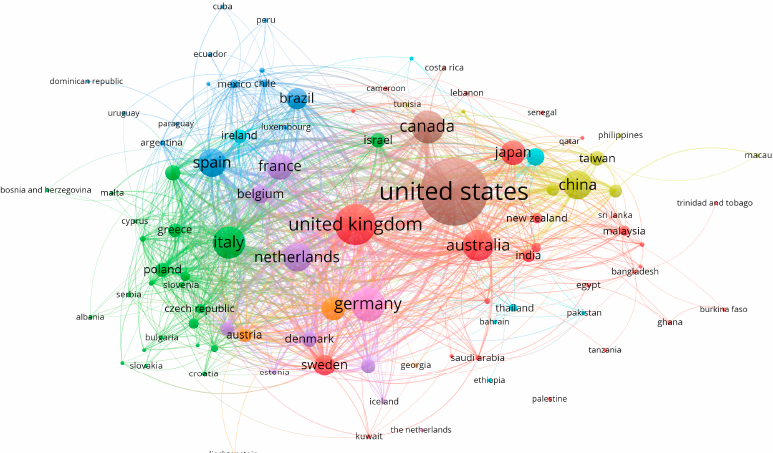
Figure 8. Map of international collaborations considering countries with at least two publications on the topic of “healthy aging”. Circle size is related to the number of documents. The countries are grouped by color; those with the same color have more collaborations with each